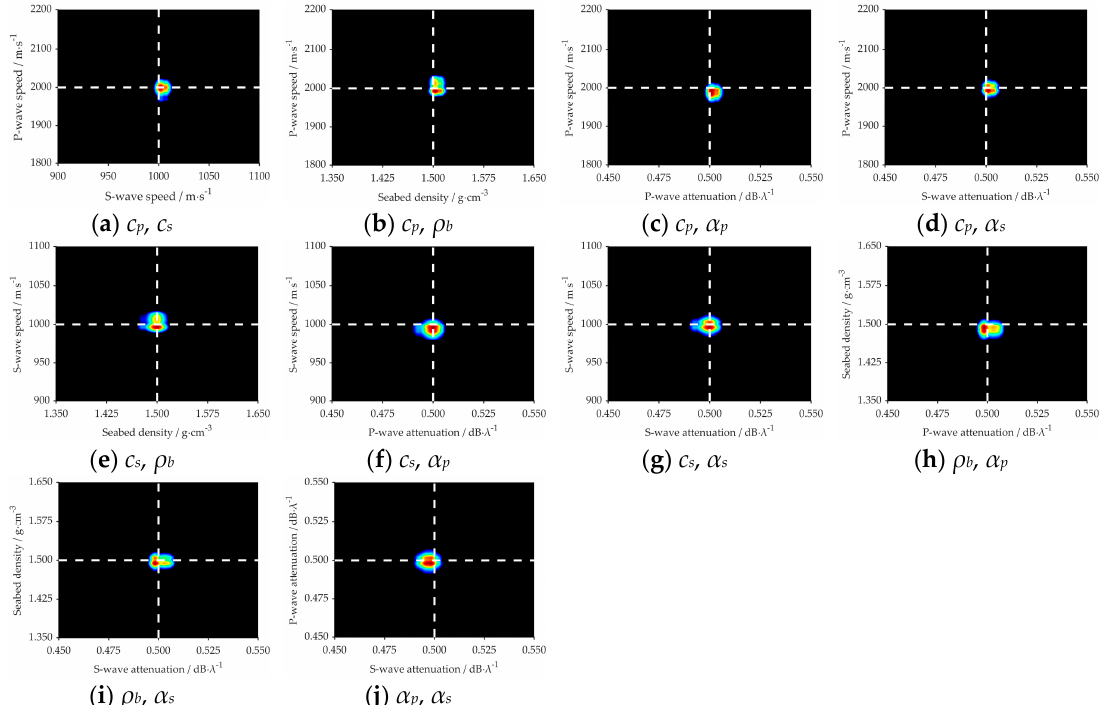
Figure 8. 2D marginal PPDs between different parameters in the noiseless sea environment. White dashed lines mark the true values of each parameter in the simulation.